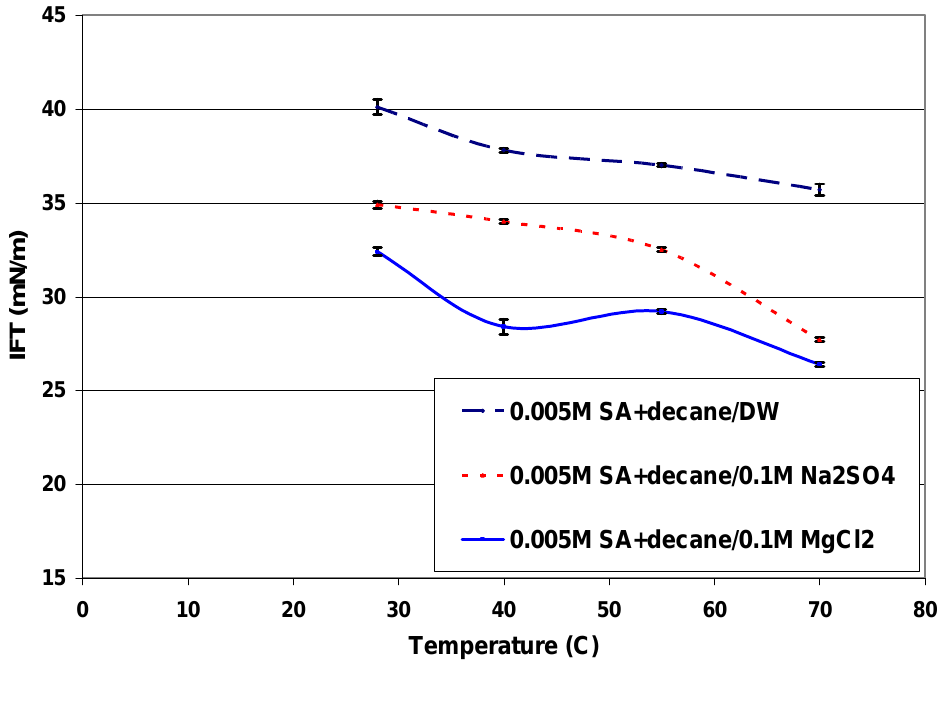
Figure 6. Comparison between the average measured IFTs of 0.005M SA dissolved in n -decane and distilled water (DW), 0.1M Na temperature. The error bars represents, the standard deviation of the experimental data varies between – 0.1to 0.4